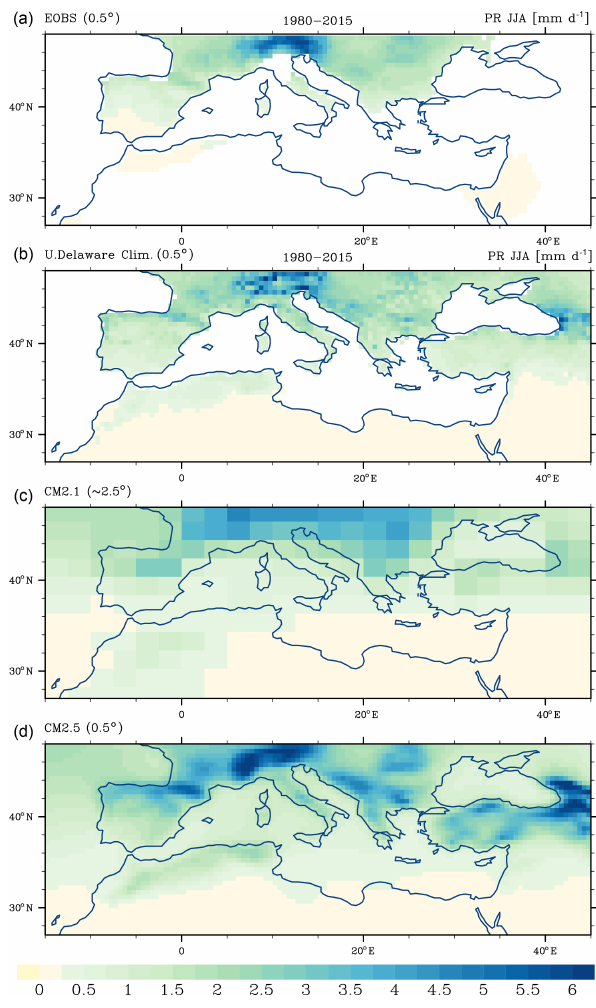
Figure 3. Seasonal (JJA) mean precipitation (mmd − 1 ) for (a) EOBS observations, (b) the University of Delaware clima- tology, (c) CM2.1, and (d) CM2.5. The time mean of seasonal data from years 101–1000 of the control simulations is used, as are years 1980–2015 of the observed datasets. Both observational datasets are shown at 0.5 ◦ lat × long resolution. Regions with miss- ing data are left blank.